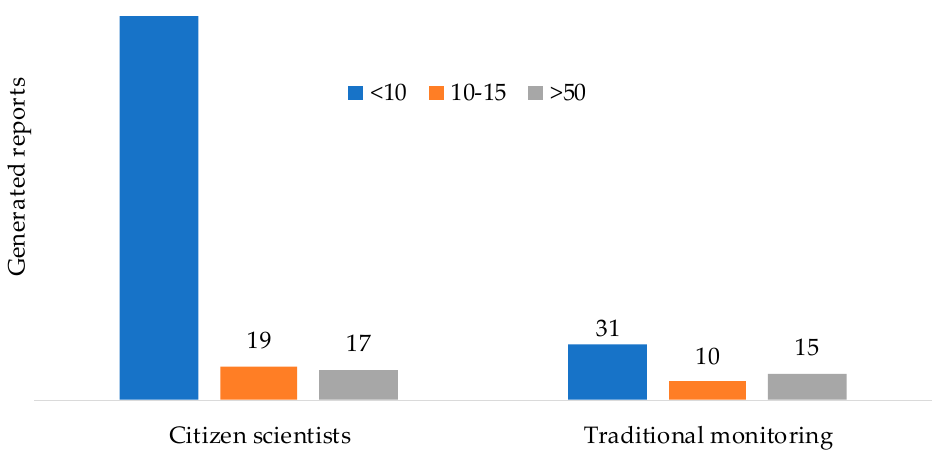
Figure 2. A representation of the different BugMap reports registered by citizens and those registered by technicians, adopting traditional monitoring methods (Pheromone traps, tree-beating). Blue bars: <10 specimens; orange bars: 10–15 specimens; grey bars: >50 specimens.